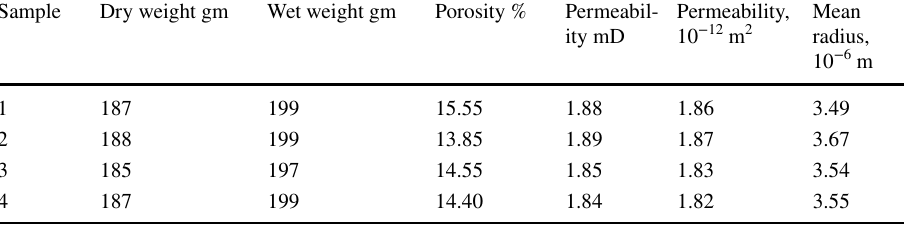
Table 8 Test results (Ullah